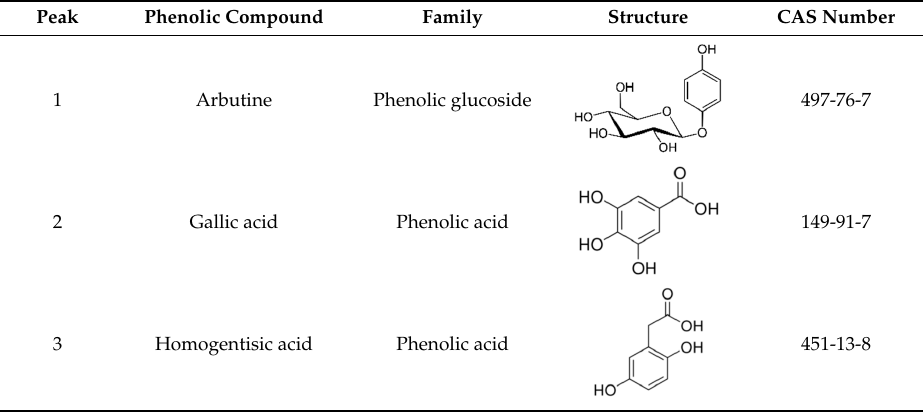
Table 1. Chemical structures and classification of the studied phenolic compounds.